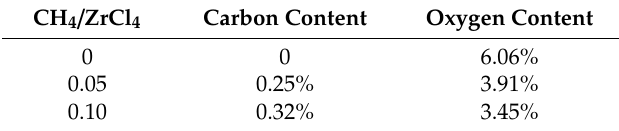
Table 2. C and O contents of the products obtained with a di ff erent mole ratio of CH 4 / ZrCl